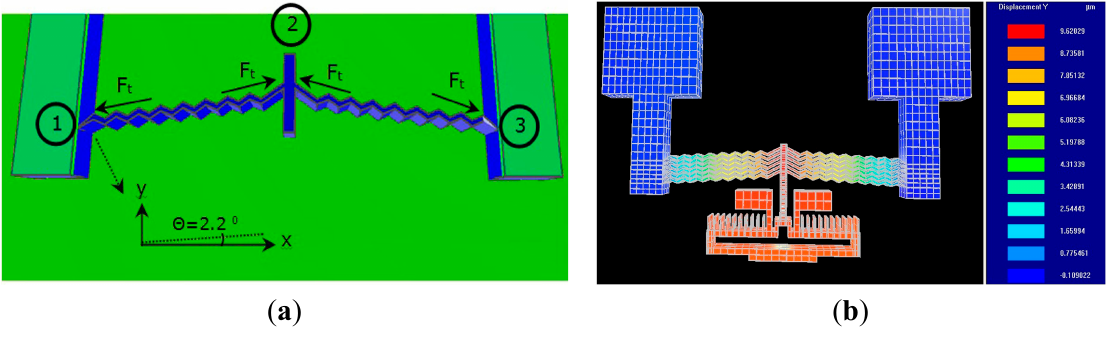
Figure 8. ( a ) Diagram of forces acting on a chevron beam ( V form). ( b ) Simulation results of obtained displacement (9.6 μm) of pump